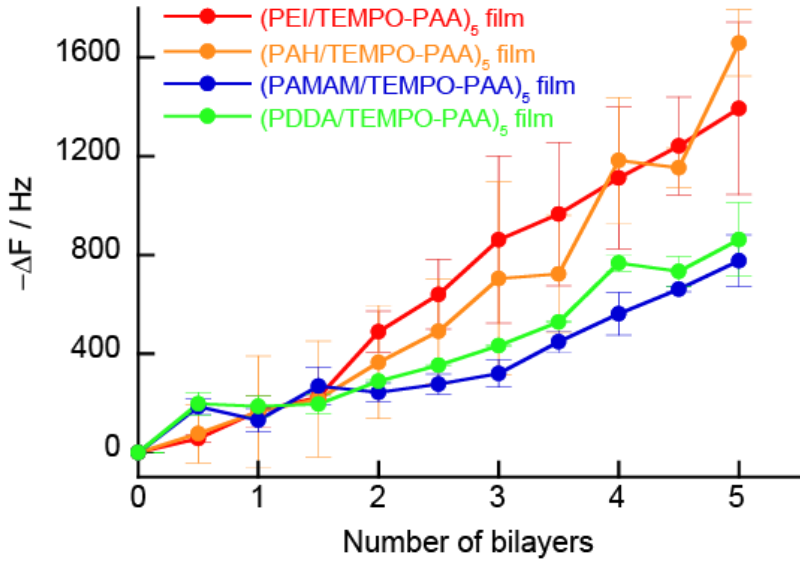
Figure 4. QCM resonator frequency changes during drying of the prepared (PEI/TEMPO-PAA) n (red), (PAH/TEMPO-PAA) n (orange), (PAMAM/TEMPO-PAA) n (blue), and (PDDA/TEMPO-PAA) n (green) films. Surface area: 0.4 cm 2 .